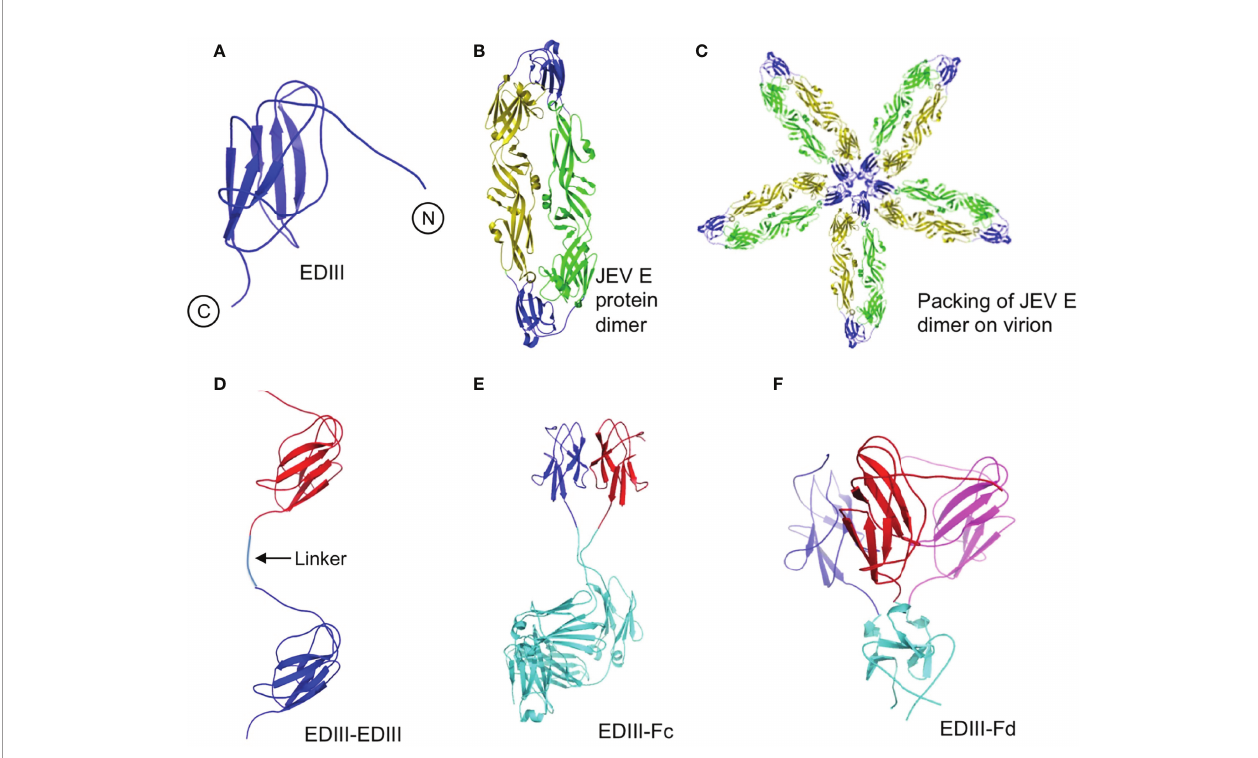
FIGURE 5 | Modeled tertiary structures of JEV EDIII fragments. (A) EDIII of JEV E protein (PDB ID: 3P54). N- and C-terminal are shown in fi gure. (B) Dimeric JEV E protein (PDB ID: 3P54). EDIII is in blue. (C) Dimeric JEV E protein packed in a fi ve-fold symmetry as on JEV virions (Kanai et al., 2006). (D) EDIII-EDIII. Two EDIII molecules (in blue and red, respectively) are linked head to tail through a short linear spacer (shown in the fi gure). (E) EDIII-Fc. Two EDIII molecules (in blue and red, respectively) are tightly packed side by side through an Fc dimerization tag (in cyan; PDB ID: 1IGT). (F) EDIII-Fd. Three EDIII molecules (in blue, red and magenta, respectively) are tightly packed side by side through a foldon trimerization tag (in cyan; PDB ID: